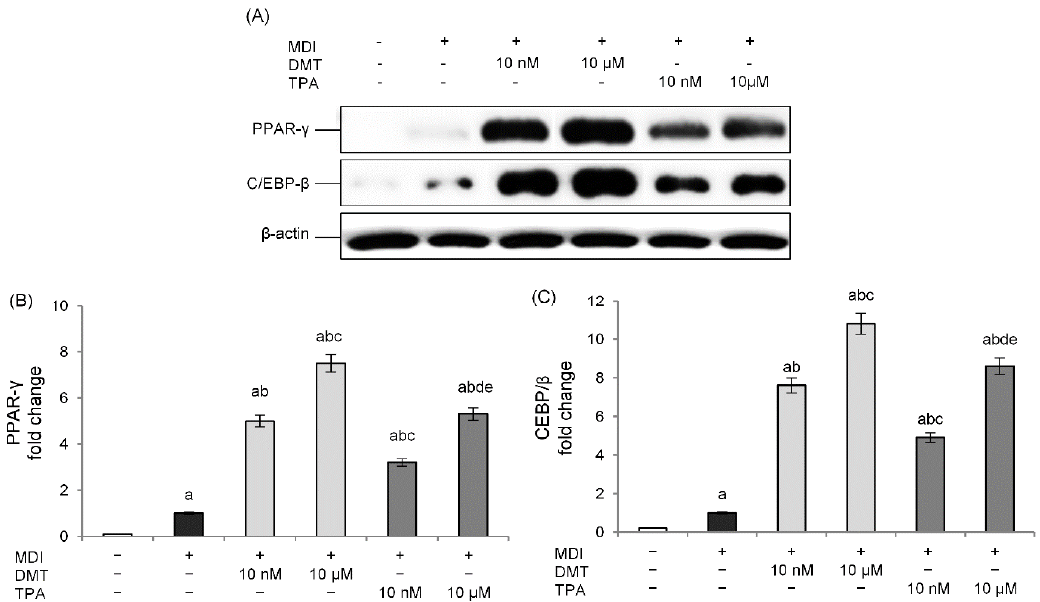
Figure 3. Effects of p-phthalates on PPAR- γ ( A , B ) and CEBP/ β ( A , C ) expression. 3T3–L1 preadipocytes were cultured in differentiation medium (MDI) containing p-phthalates (10 nM and 10 µ M) for 10 days. Cells treated with MDI alone were used as controls. Undifferentiated cells were cultured in standard medium for 10 days. The densitometry results ( B , C ) are reported as fold change compared to MDI. The intensity values of the PPAR- γ and CEBP/ β protein were normalized to the corresponding values of β -actin. All data are expressed as mean ± SD of three independent experiments. a p < 0.05 vs. undifferentiated cells; b p < 0.05 vs. MDI; c p < 0.05 vs. DMT 10 nM; d p < 0.05 vs. DMT 10 µ M; e p < 0.05 vs. TPA 10 nM.